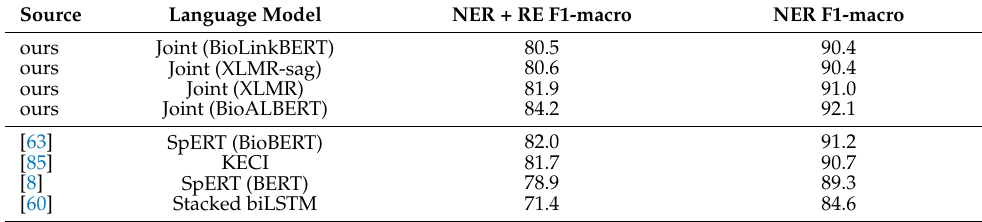
Table 10. An accuracy of NER and RE tasks on ADE dataset (joint approach).